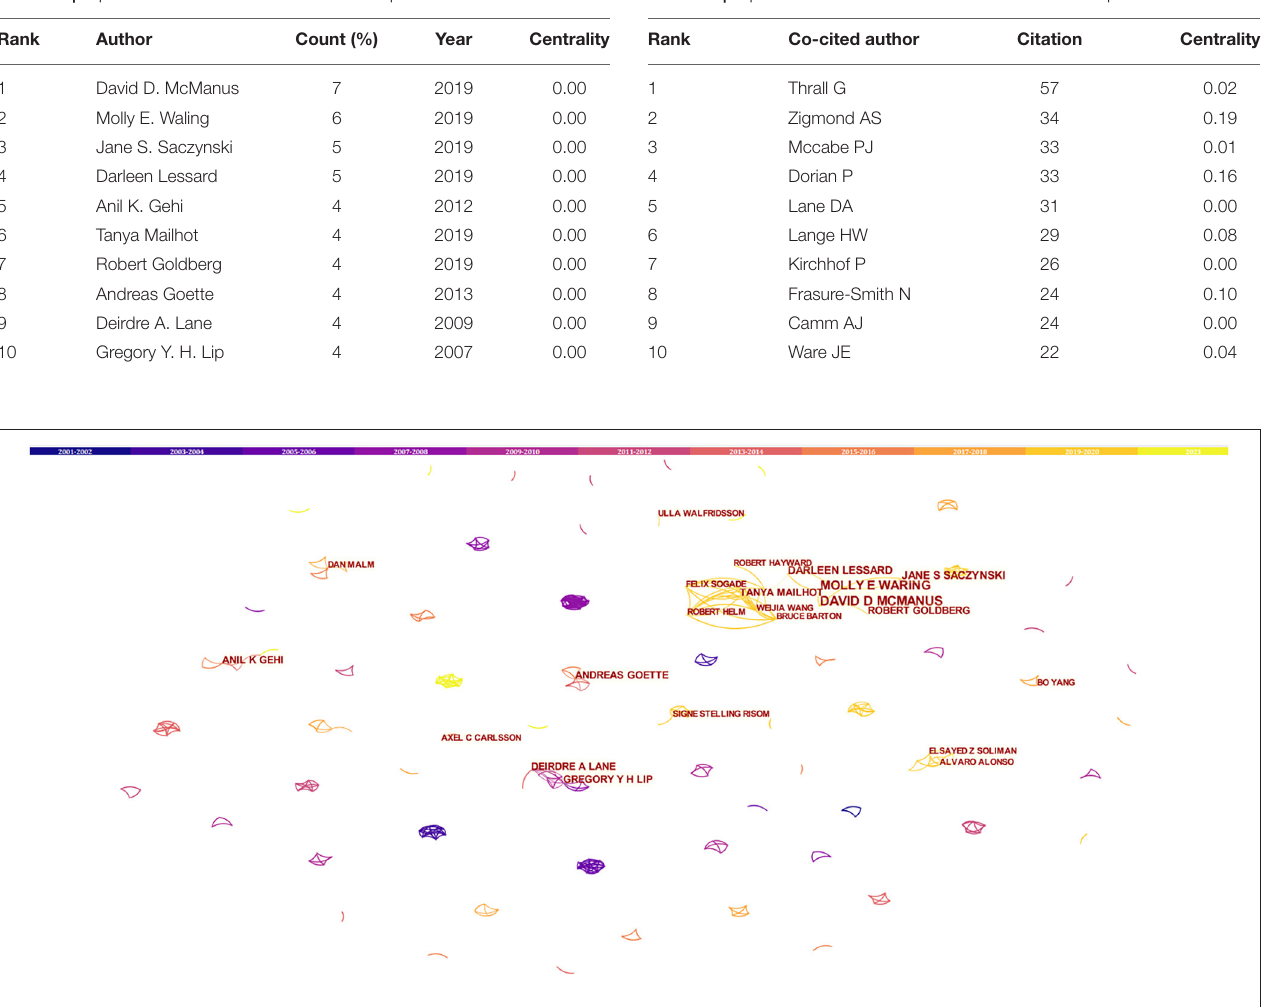
FIGURE 3 | The network of authors contributed to research about atrial fibrillation and depression. In the network, the larger the node was, the more contribution the author had made to that field. The color of the line represents the time of first co-occurrence. The thicker the line is, the greater the connection strength is (calculation method based on